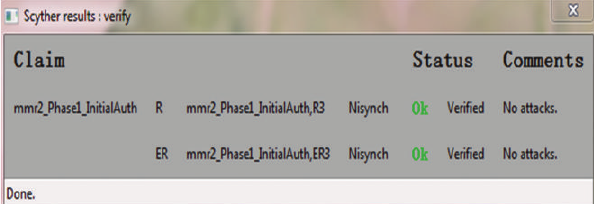
Figure 5: Verification result for Protocol 2-Phase 1, initial authenti- cation.